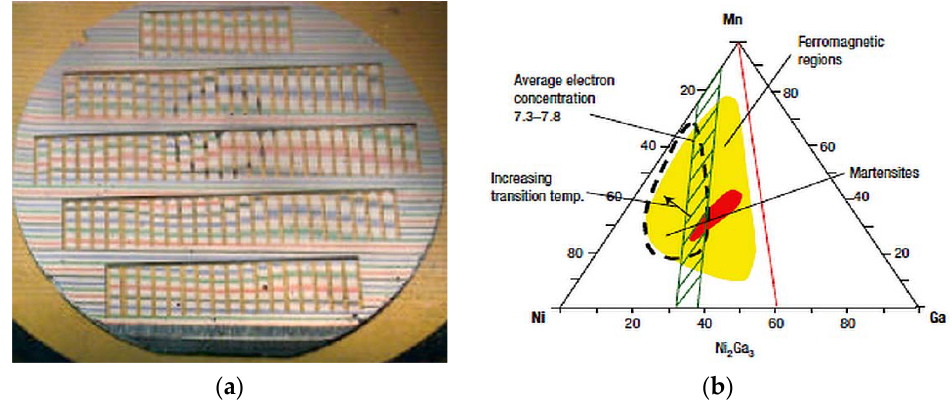
Figure 13. ( a ) Photograph of the cantilever library; ( b ) functional phase diagram of the Ni ‐ Mn ‐ Ni 2 Ga 3 alloy system [117], with copyright permission from © Nature Publishing Group .